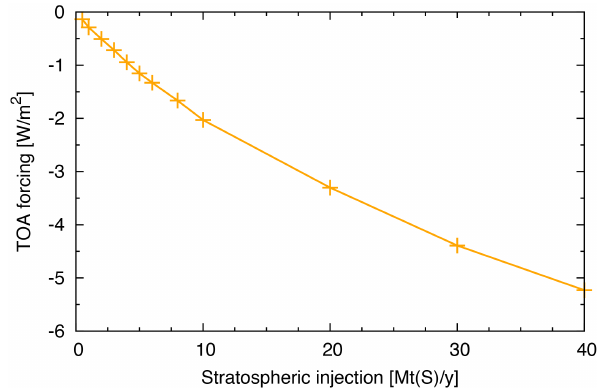
Figure 7. This figure shows the amount of annual stratospheric injection ( x axis) required to offset a given level of TOA net ra- diative flux imbalance ( y axis) in MPI-ESM-LR, a general circu- lation model of Earth’s climate. Sulfate aerosol optical depth dis- tributions were prescribed in the model from ECHAM5-HAM, an atmospheric general circulation model with a treatment of the mi- crophysical evolution of sulfate aerosols. Maintaining 2020 val- ues of net TOA radiative flux imbalance against a background of RCP8.5 requires an injection of approximately 70TgSyear − 1 in 2100 (based on extrapolation of the above values). All values were calculated for injection of SO 2 into one grid box over the Equator; other injection strategies would likely require a different injection rate to achieve the same radiative forcing. Results differ somewhat from those of Niemeier and Timmreck (2015), who describe radia- tive forcing results solely from ECHAM5-HAM; their treatment of the aerosols is fully internally